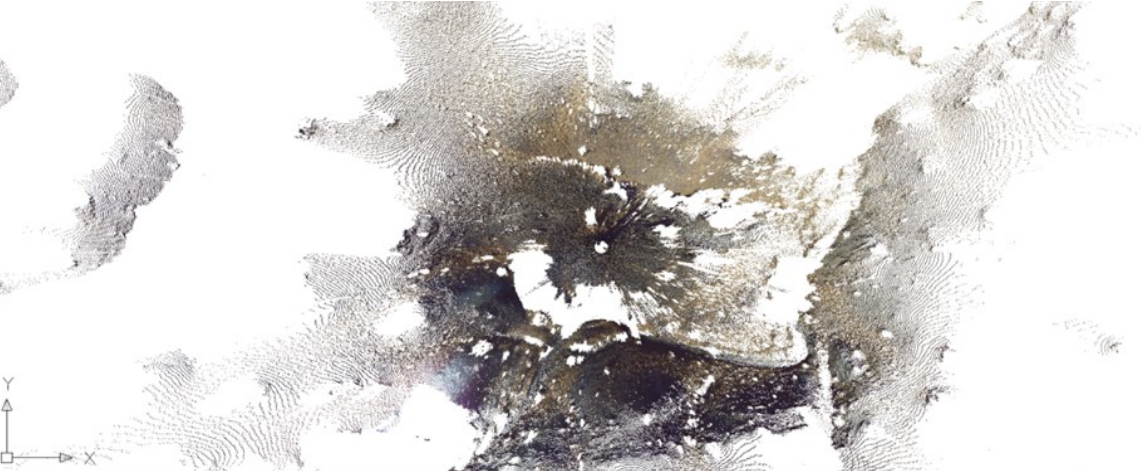
Fig. 3. Point clouds data of surveying with laser scanner